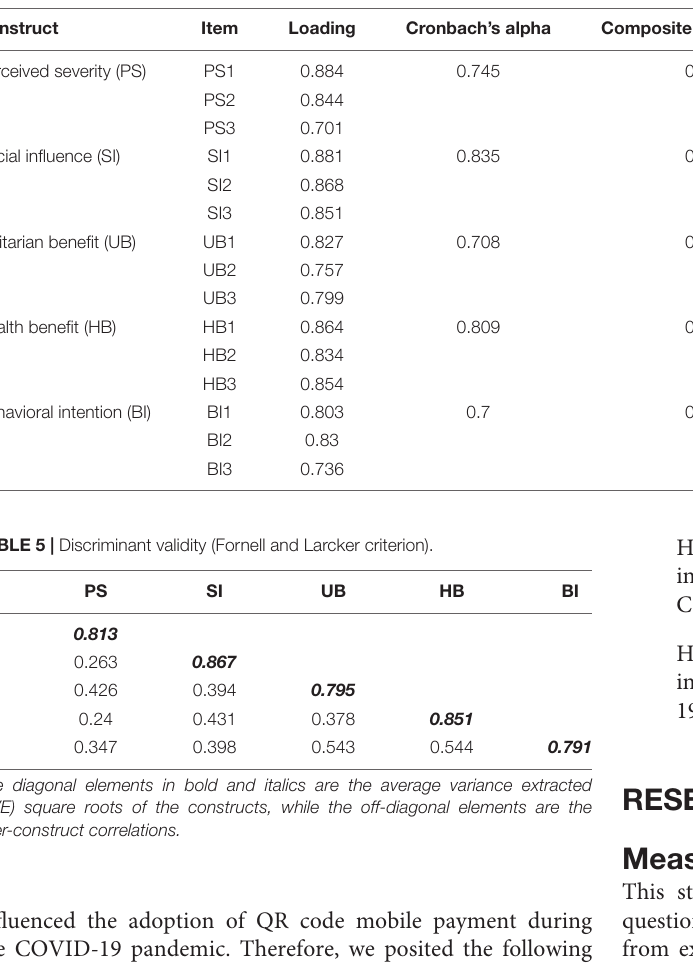
TABLE 4 | Results of convergent validity tests.